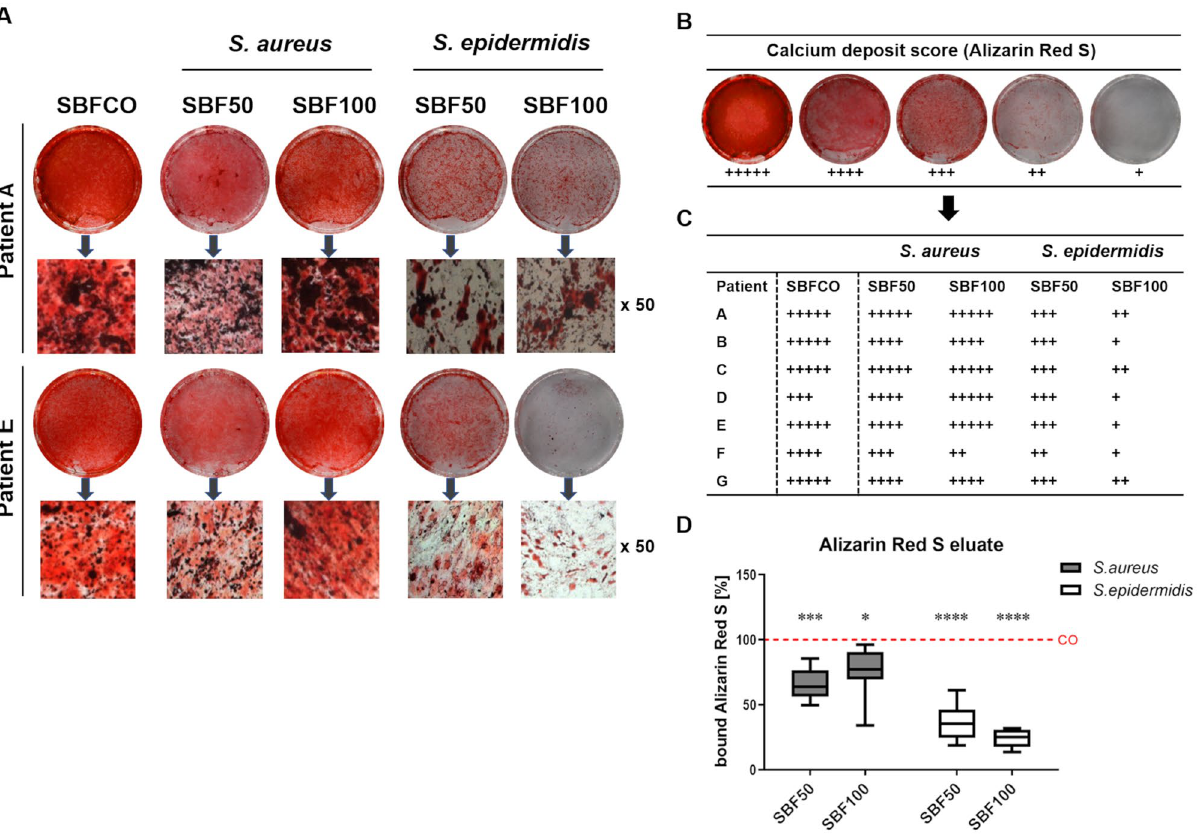
Figure 6. SBF impacts calcium deposits produced by osteoblasts. The calcium deposits were dyed with Alizarin Red S stain after incubation for 28 days, representative images from 2 donors are shown ( A ). Calcium deposit score ( B ). Semi quantitative evaluation of all 7 patients by using the calcium deposit score ( C ). Quantification of bound Alizarin Red by photometric measurement ( D ). *p ≤ 0.05, **p ≤ 0.01, ***p ≤ 0.001, ****p ≤